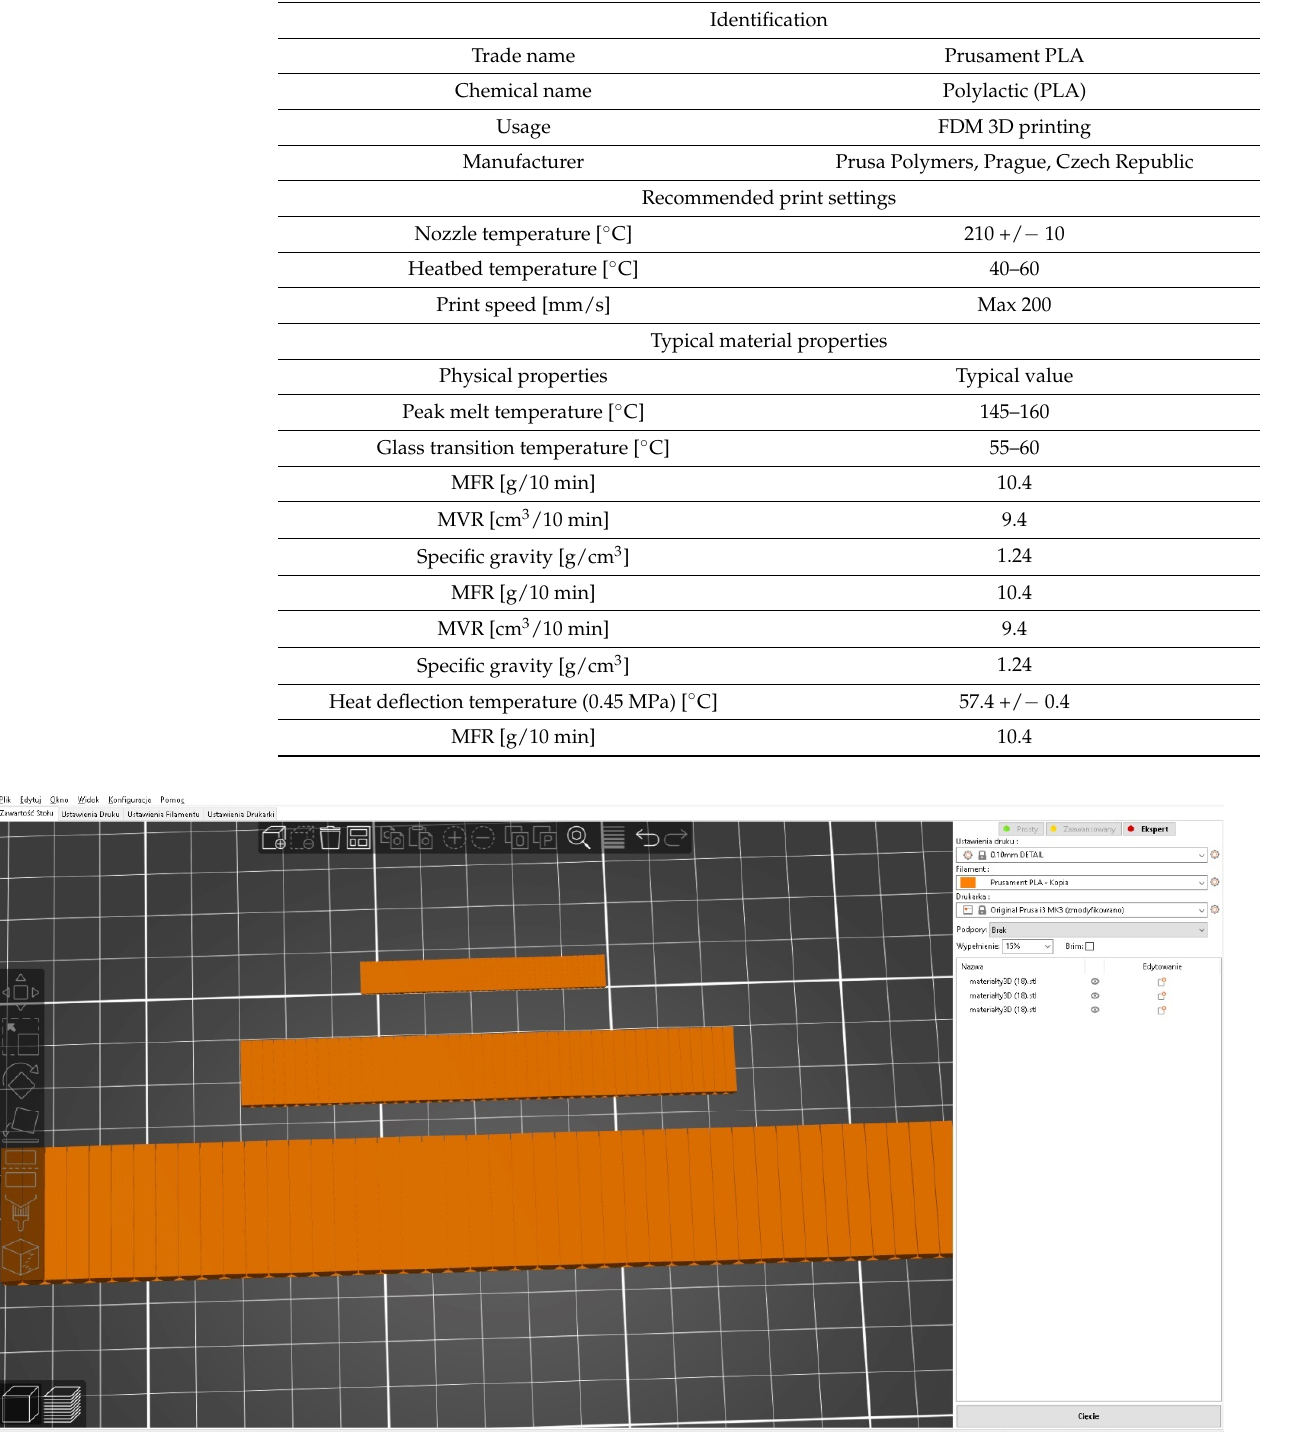
Figure 7. Material models in three sizes (from the biggest) original 50% version 5% version.